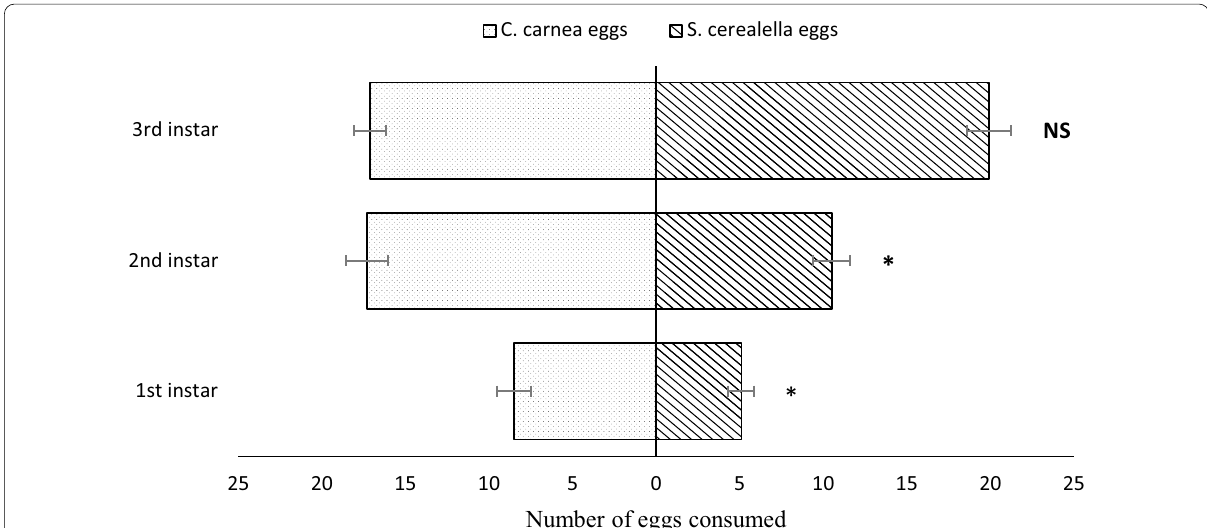
Fig. 3 Horizontal bars indicate average number of eggs consumed by specific C. carnea instars. All horizontal lines indicate each bar. Asterisk beside the bars indicates significant difference between consumed egg proportion of C. carnea or S. cerealella by C. carnea instars